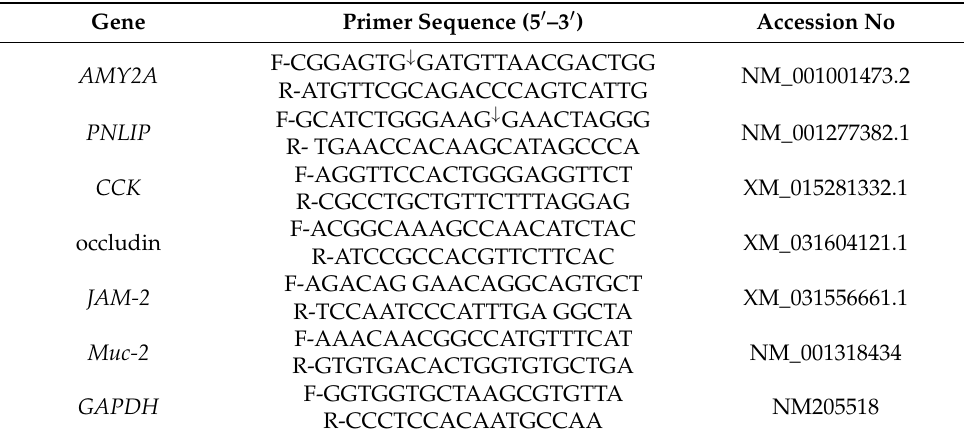
Table 2. Primer sequences of target and reference genes analyzed in a reverse transcription quantita- tive real-time PCR